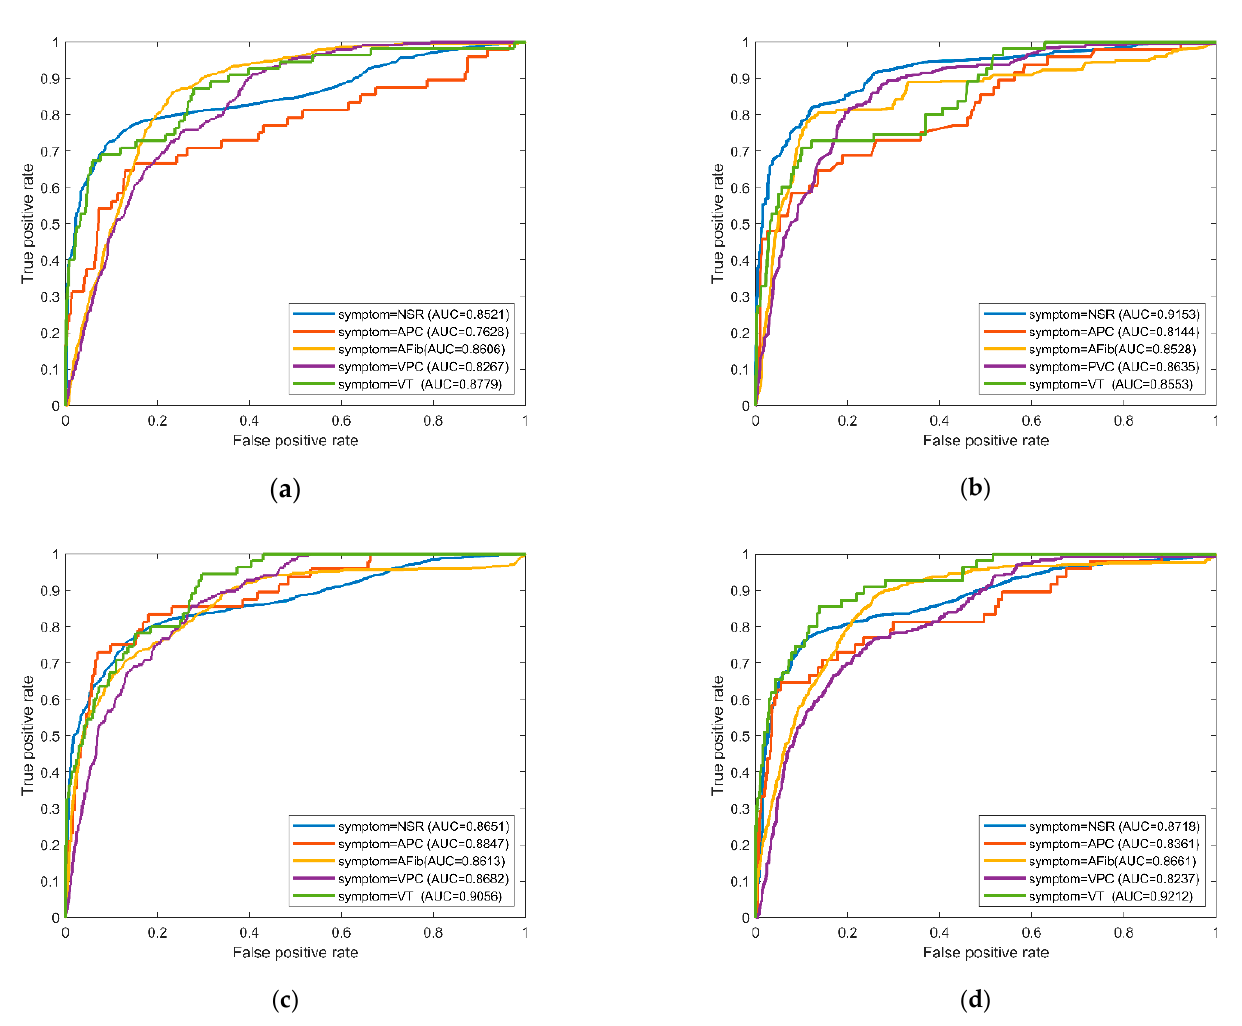
Figure 6. The ROC curves of the arrhythmia symptoms with one-versus-rest plots for the ML mod- els’ coupling analysis by training data set (A) and testing data set (B): ( a ) MLP model; ( b ) RF model; ( c ) SVM model; ( d ) NB model.